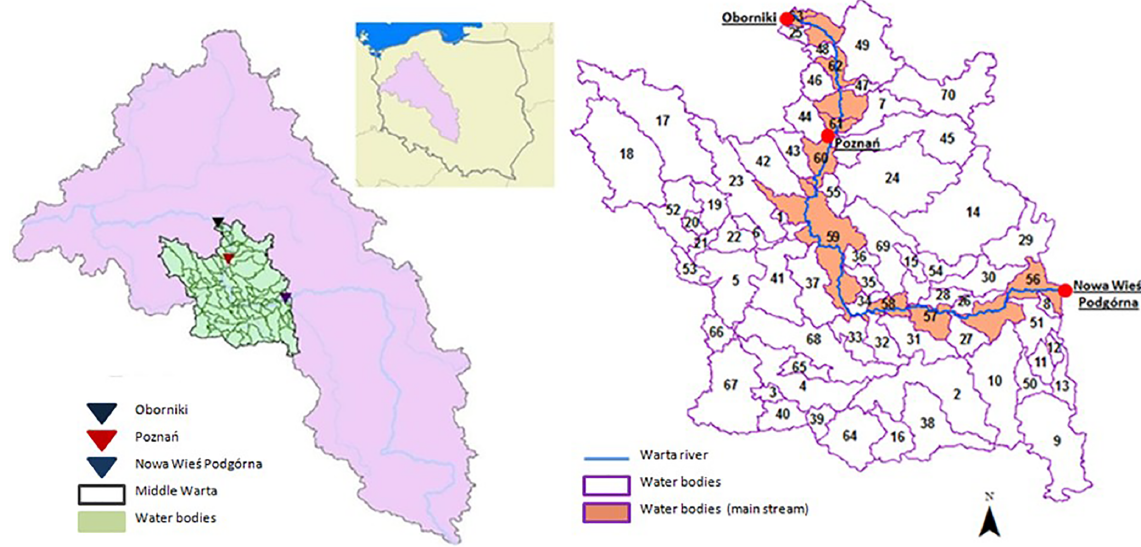
Figure 5. Location of catchments in Poland the Middle Warta catchment with an indication of profiles for calibration and verification (Pozna´n) and validation (Oborniki).